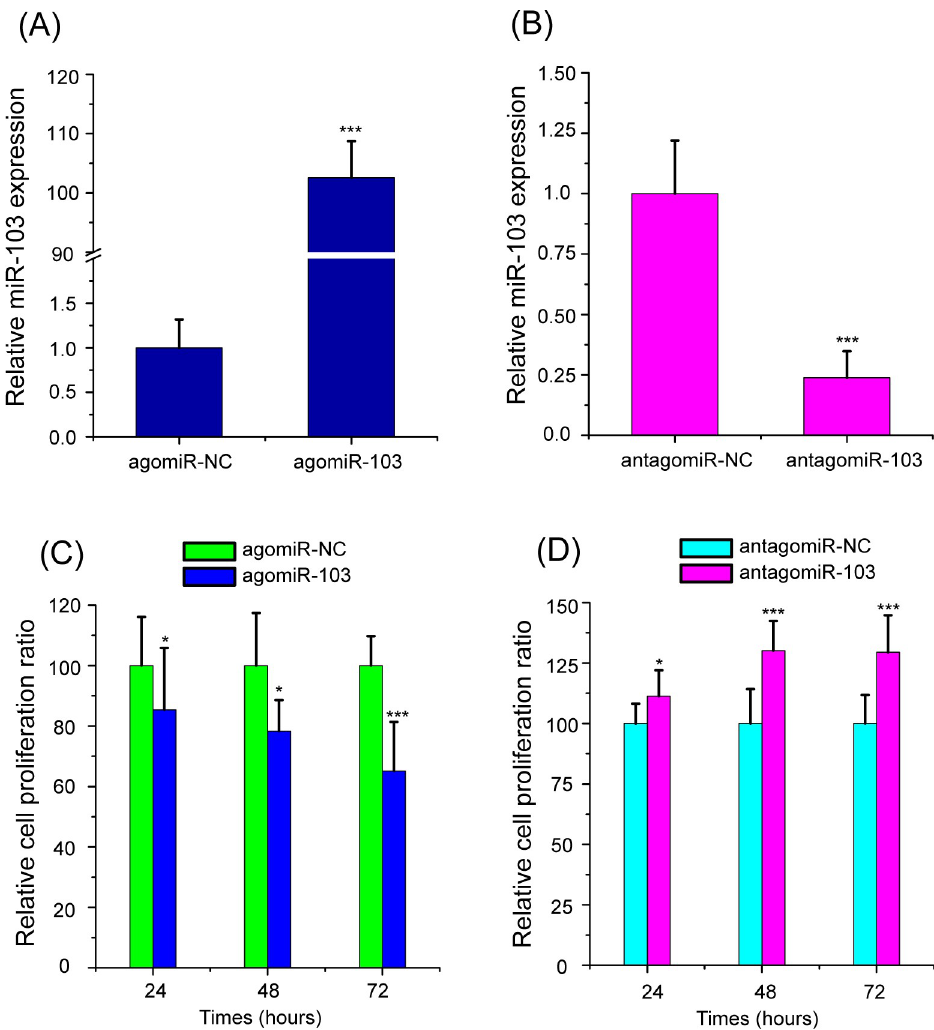
Fig 2. miR-103 suppresses the proliferation of HBMScs. (A) Elevated expression of miR-103 was determined by real-time qPCR when HBMScs were transfected with agomiR-103. (B) The expression of miR-103 was significantly downregulated in BMMSCs after treated with antagomiR-103. (C) A CCK-8 assay demonstrated that overexpression of miR-103 retarded the growth of HBMScs in vitro . (D) Knockdown of miR-103 promoted HBMScs proliferation ability. Data are shown as the mean ± SD of three independent experiments. � p < 0.05, ��� p <